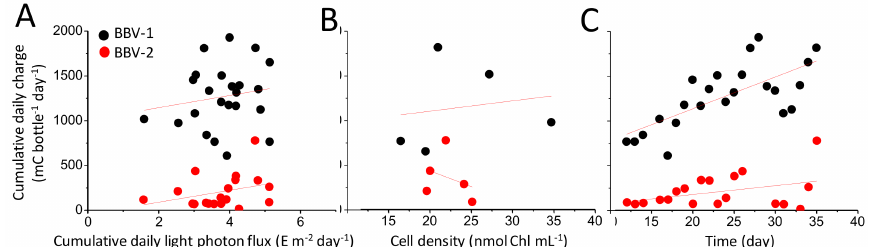
Figure 6. Charge accumulation versus light photon flux, cell density, and time. ( A ) The cumulative daily charge for two BBV systems (BBV-1 is shown in black and BBV-2 is shown in red) is plotted against the cumulative daily light photon flux. ( B ) The cumulative daily charge for two BBV systems is plotted against the cell density. The measurements were taken on different days. ( C ) The cumulative daily charge for two BBV systems is plotted against the time. The above data relate to the steady state only (from day 12 to day